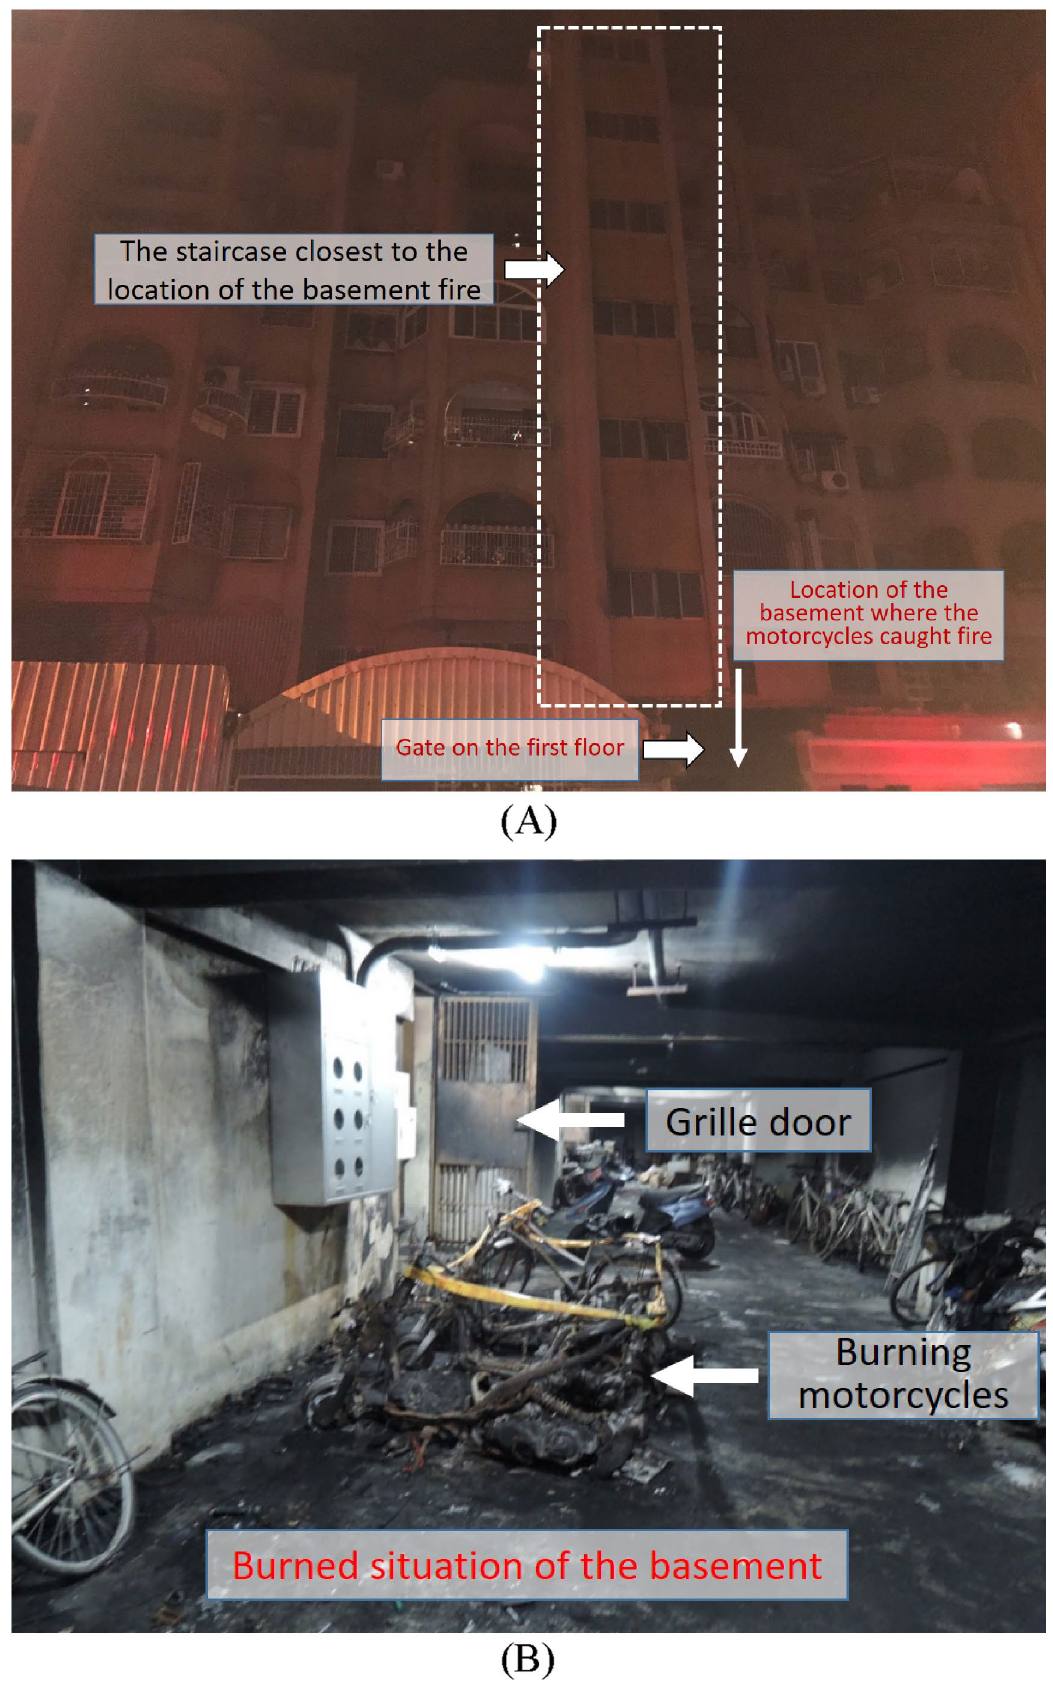
Figure 3. Description of the analyzed case ( A ) The appearance of the building. ( B ) The fire location in the